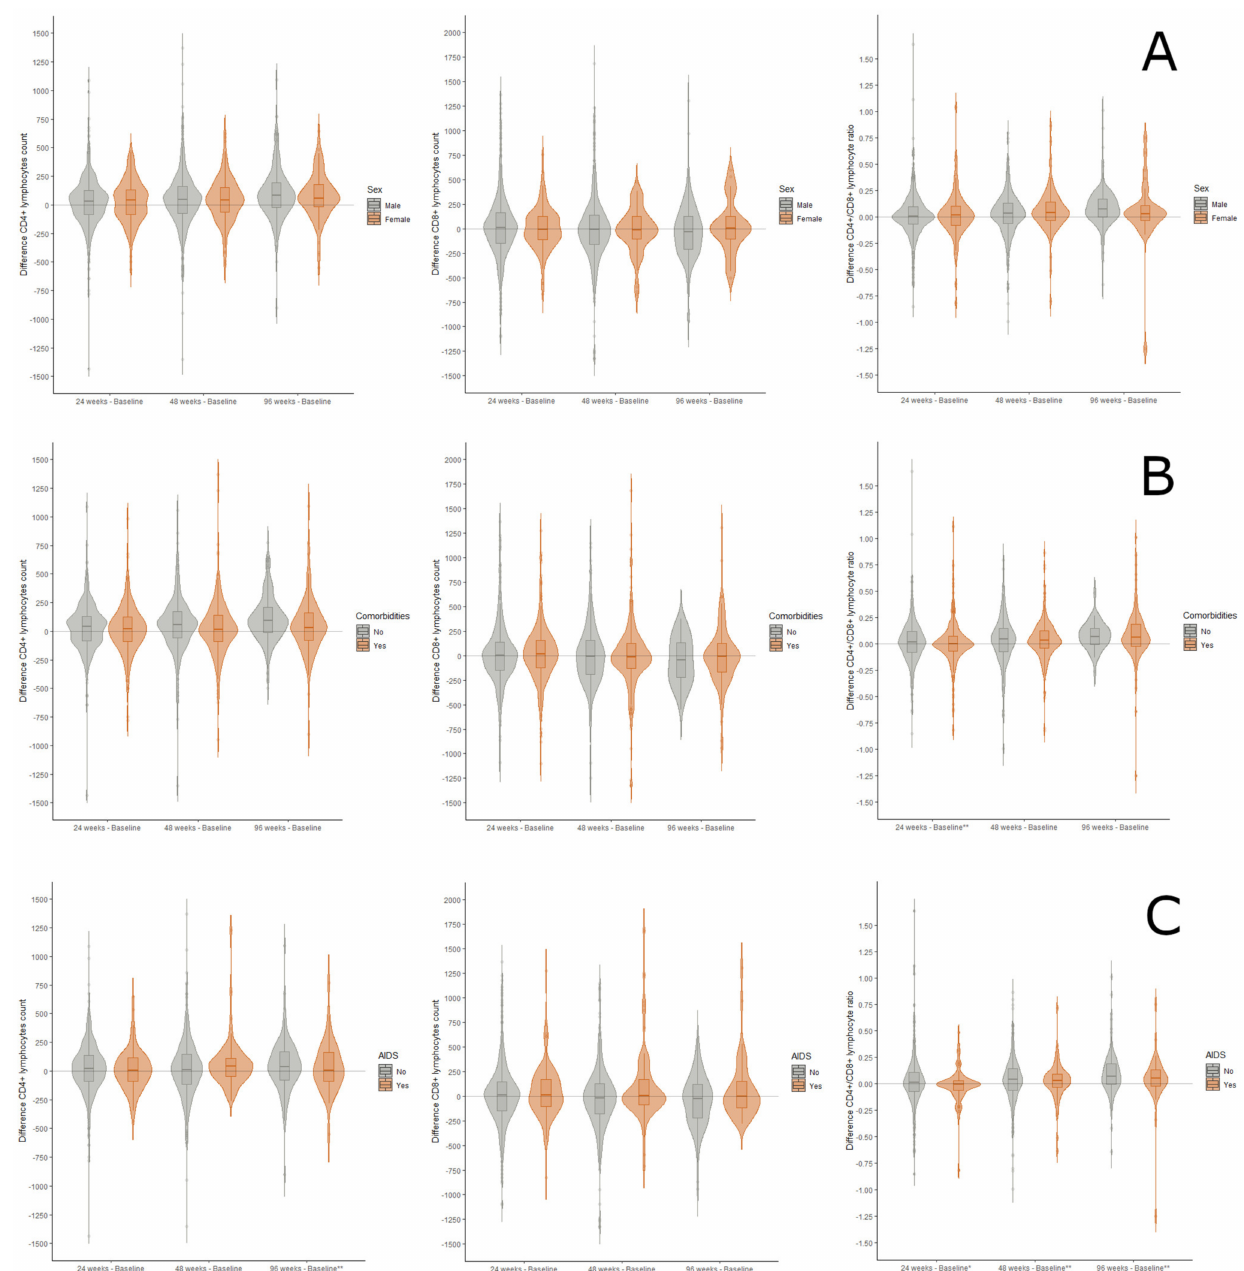
Figure 1. Difference between baseline absolute CD4+ lymphocytes (cells/mm 3 ), baseline absolute CD8+ lymphocytes (cells/mm 3 ), and baseline CD4/CD8 ratio of HIV-positive patients at 24, 48, and 96 weeks of DTG plus 3TC treatment. Panel ( A ): Gender differences; Panel ( B ): Differences between patients with and without comorbidities; Panel ( C ): Differences in patients with and without AIDS. Significant values: p -value < 0.05 = *; p -value < 0.01 = **. Regarding immune status, patients with AIDS presented, as expected, a lower lym- phocyte count (around 150–200 cells/mm3 less than non-AIDS patients) without paired data analysis. Nevertheless, the absolute value of CD8+ lymphocytes remained constant in both groups. This trend translates into a lower CD4+/CD8+ ratio in the AIDS group up to week 48 of dual DTG plus 3TC